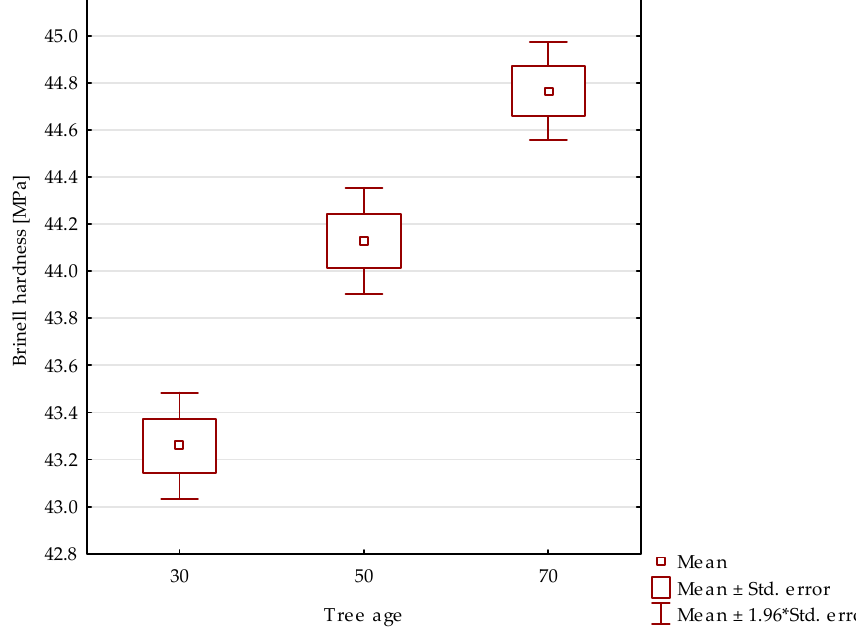
Figure 4. Mean wood hardness values for trees of different ages.